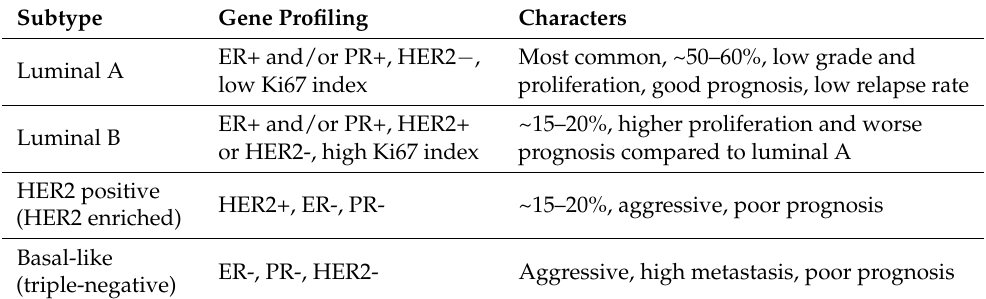
Table 1. Breast cancer subtypes based on gene expression